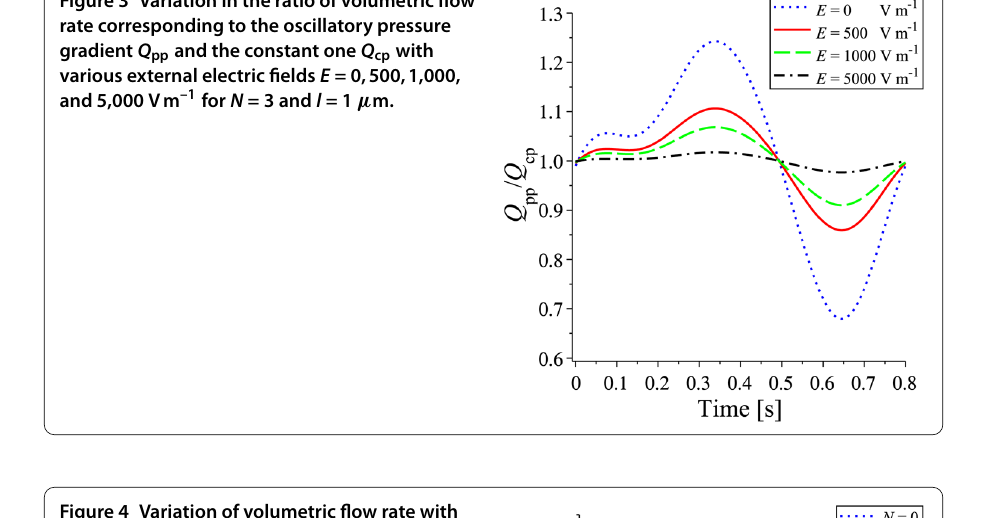
Figure 4 Variation of volumetric flow rate with various numbers of the Fourier expansion terms of the pressure gradient using N = 0,1,2,and 3 for l = 1 μ m and E = 500 Vm –1